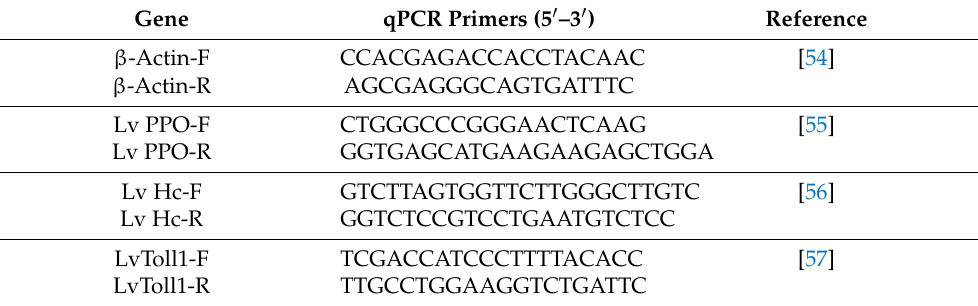
Table 1. Sequences of primer pairs used in the quantitative real-time PCR reactions.